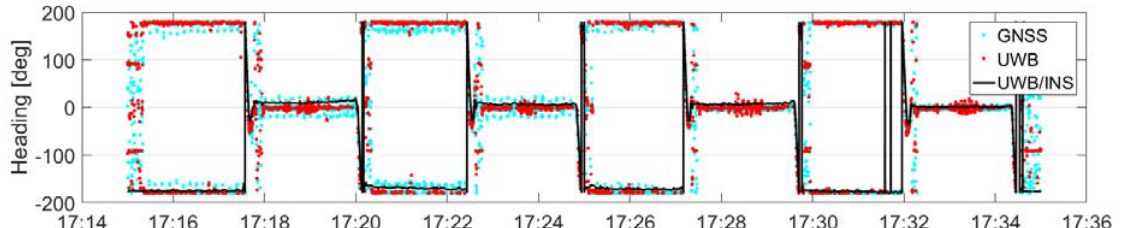
Figure 7. UWB/IMU integrated solution (black line), heading calculated from the UWB positions (red) and GPS positions (light blue) from the open-sky test